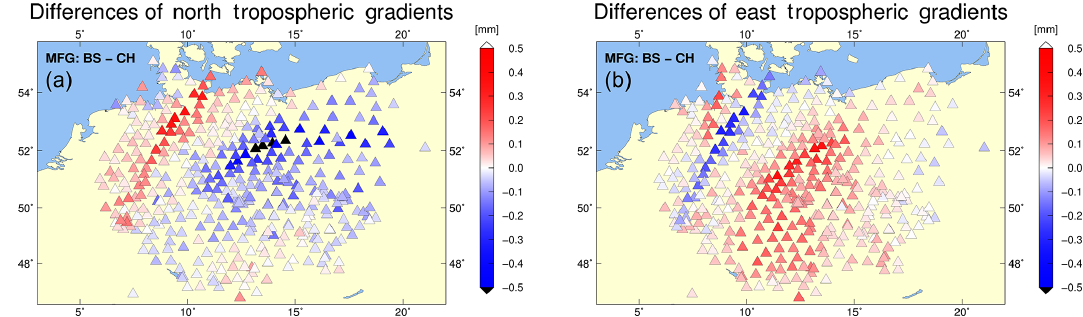
Figure 7. Mean differences (calculated over the full day of 31 May 2013) of the tropospheric north-gradient component (a) and east-gradient component (b) due to different mfg: Chen and Herring (CH) and Bar-Sever (BS) when using the SINEL2 observation weighting schemes.